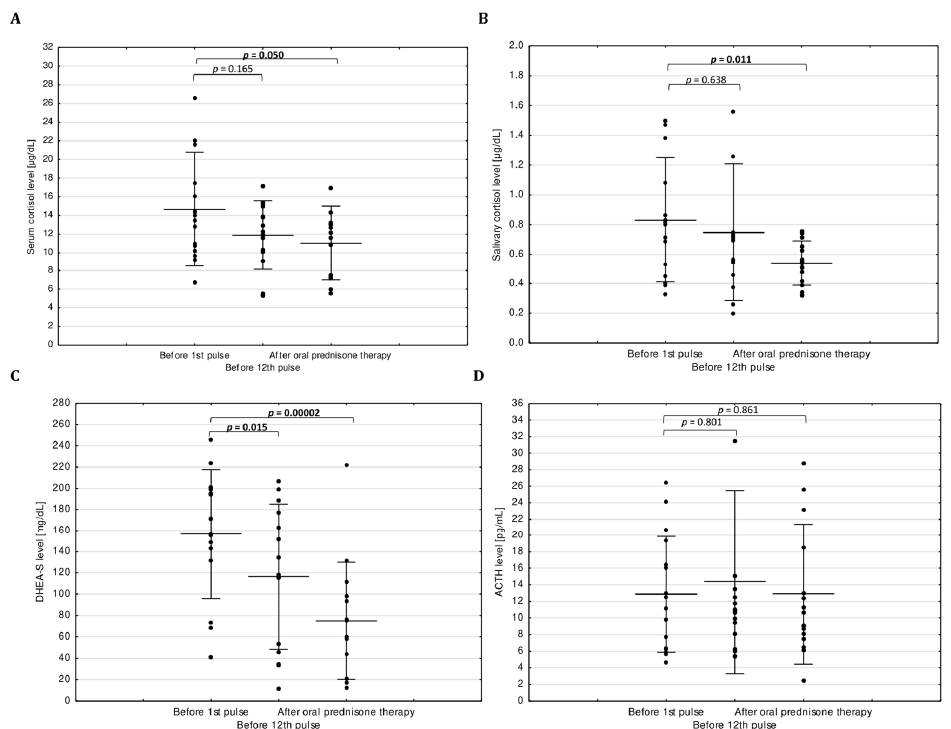
Figure 1. Comparison of variables during intravenous methylprednisolone treatment. ( A ) and ( B ) show cortisol levels in serum and saliva, respectively; ( C ) shows serum DHEA-S levels; ( D ) shows plasma ACTH levels. Abbreviations: ACTH, adrenocorticotropic hormone; DHEA-S, dehydroepiandrosterone sulfate; normal ranges: serum cortisol 6.2–19.4 µ g / dL; salivary cortisol 0.11–1.29 µ g / dL; ACTH 7.2–63.6 pg / mL; serum DHEA-S age and sex-adjusted reference ranges were used.